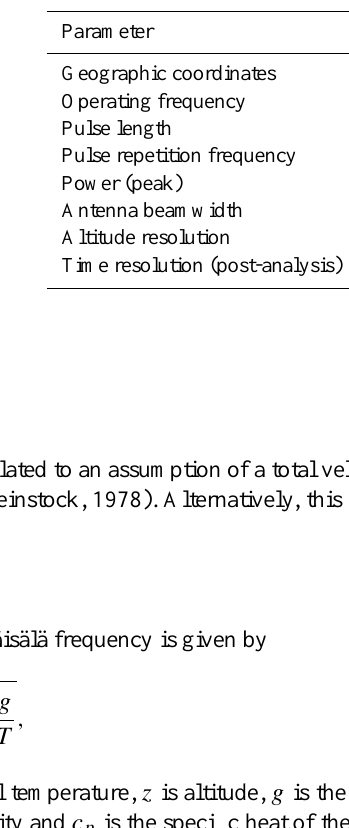
Table 1. Salient radar